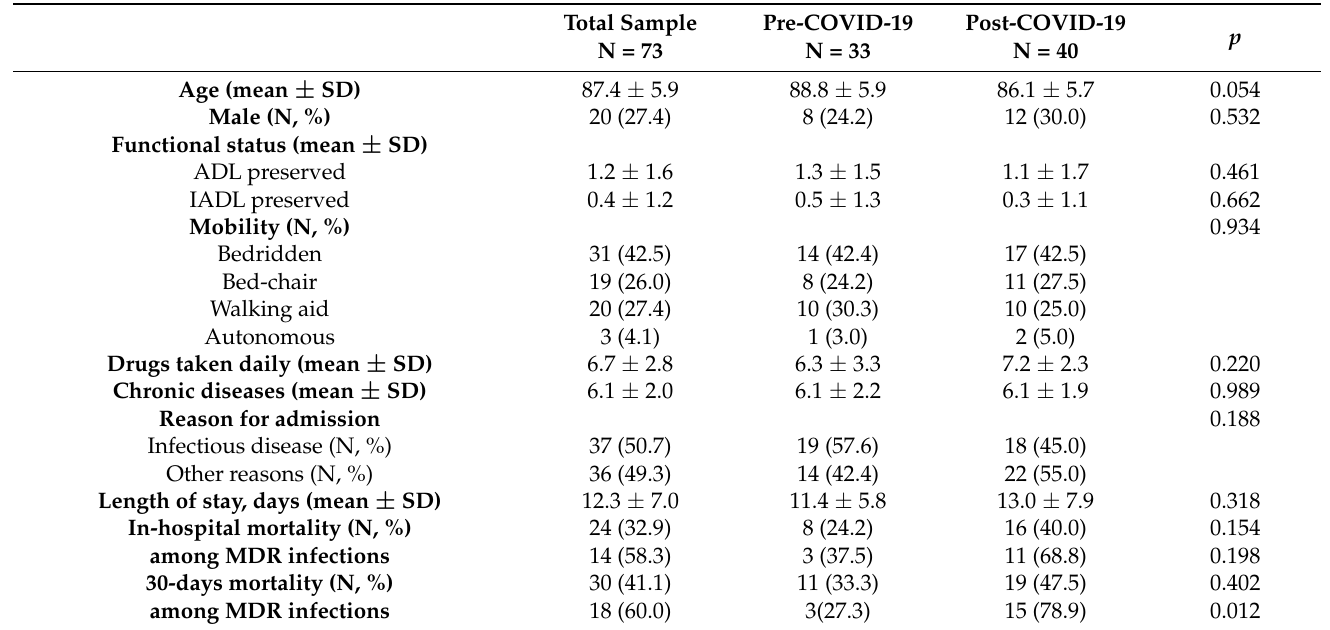
Table 1. Patients characteristics according to the period of hospital admission (pre-COVID-19, from 1 December 2019 to